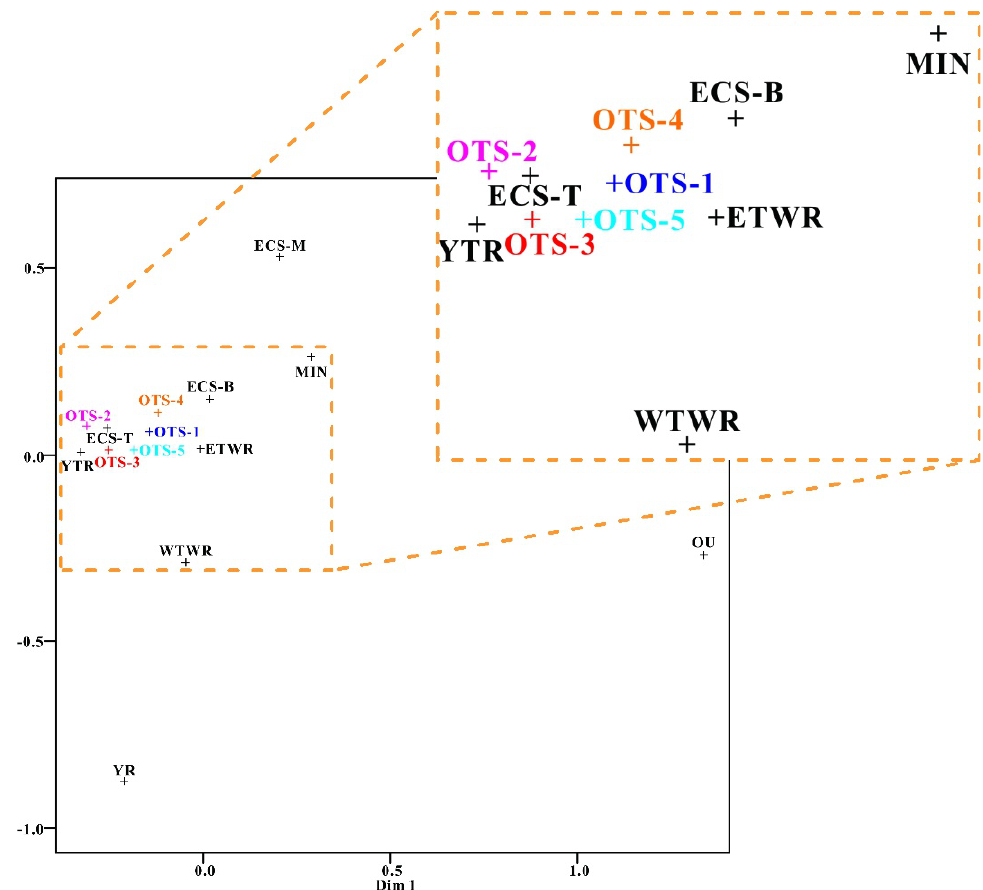
Figure 6. Multidimensional scaling (MDS) plot for detrital zircon U-Pb ages of H4-S2 and potential provenance areas. The orange dotted line shows an enlargement of part of this figure.